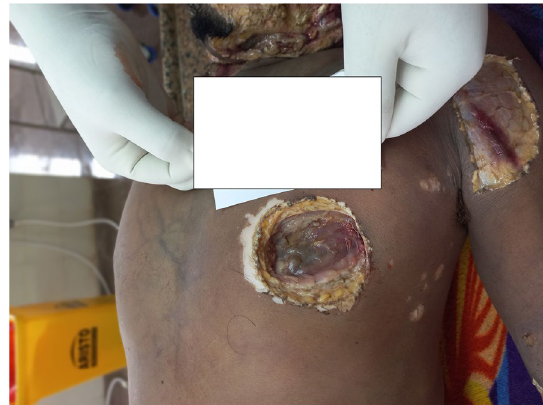
Fig. 2 Aquatic predator activity (freshwater crab)—circular defect on the front of the left side of the chest